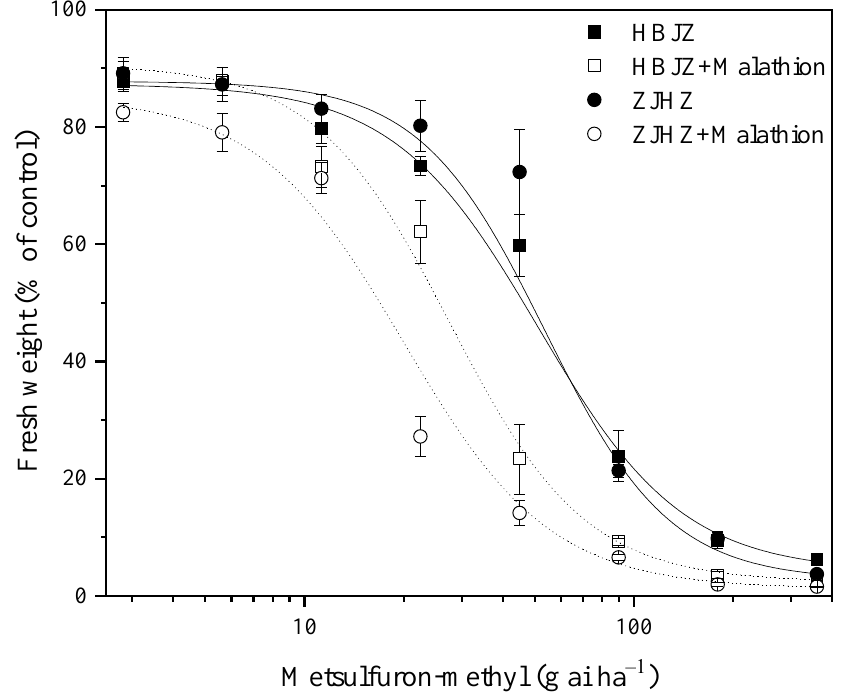
Figure 2. Dose–response curve for the fresh weight (% of control) of the HBJZ and ZJHZ R. kamoji populations treated with different doses of metsulfuron-methyl with or without malathion pretreatment. Each point is the mean ± SE of twice-repeated experiments, each including four replicates.